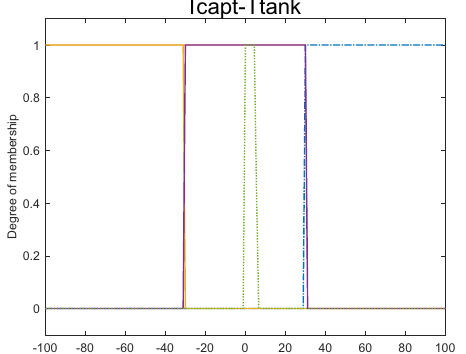
Figure 14. Inputs memberships functions of variable T capt − T tank